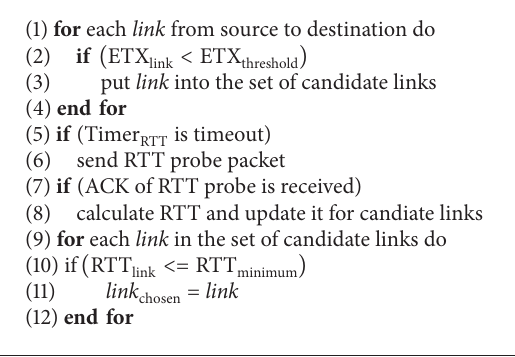
Algorithm 1: The algorithm of opportunistic routing